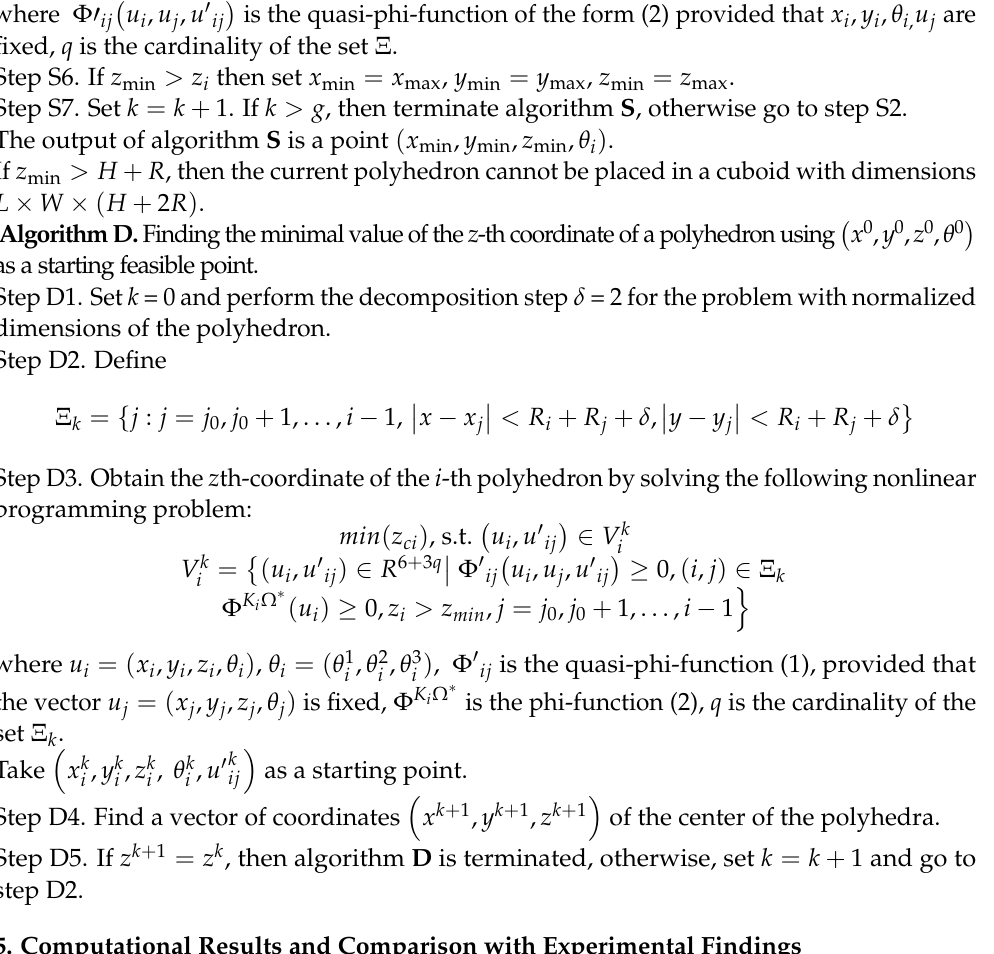
(cid:0) (cid:1) x 0 , y 0 , z 0 , θ 0